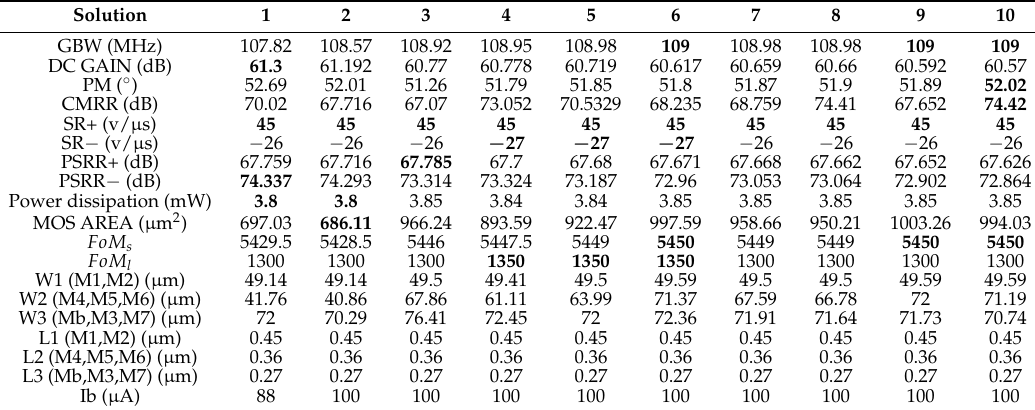
Table 3. Electrical characteristics and feasible W/L sizes of the Miller OTA guaranteeing DCOP conditions of the MOS transistors applying MOL for the best 10 runs. The best values are highlighted in bold